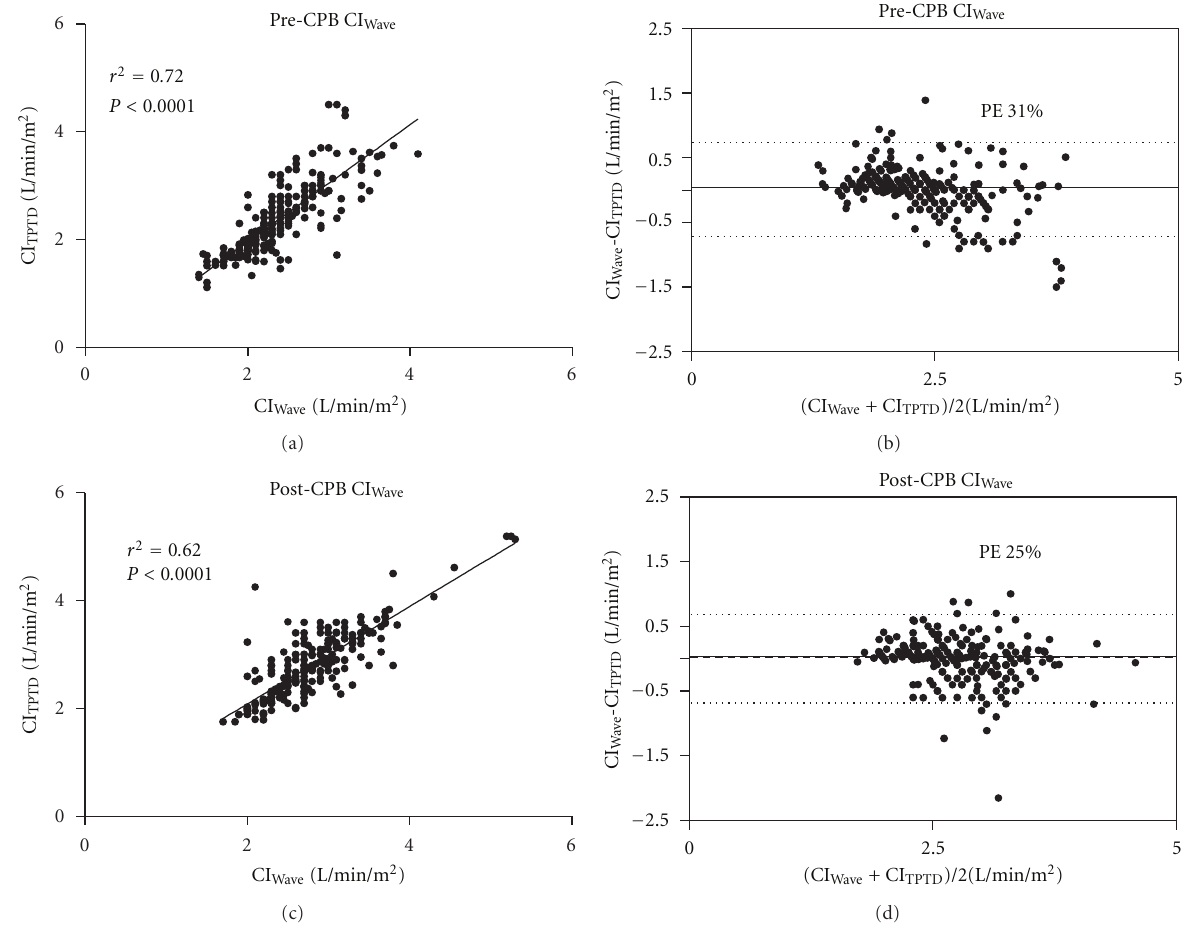
Figure 2: Correlation and Bland-Altman analysis of cardiac index measured by transpulmonary thermodilution (CI TPTD ) and cardiac index measured by uncalibrated semi-invasive pulse contour analysis (CI Wave ) before (T1) and after (T2) cardiopulmonary bypass.